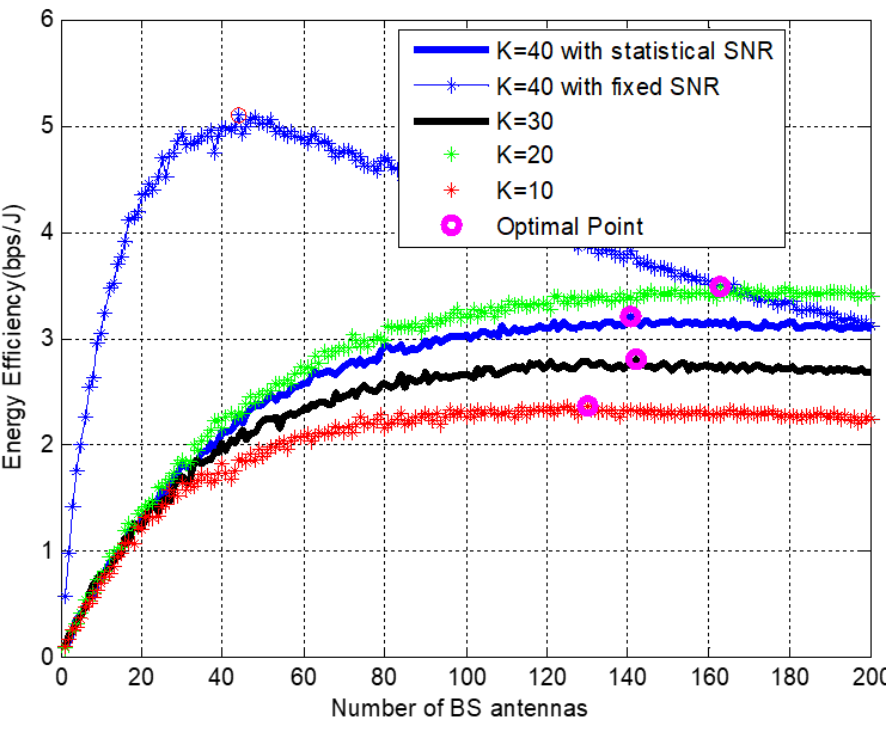
Figure 7. Energy efficiency as a function of M base station antennas with P t = 20